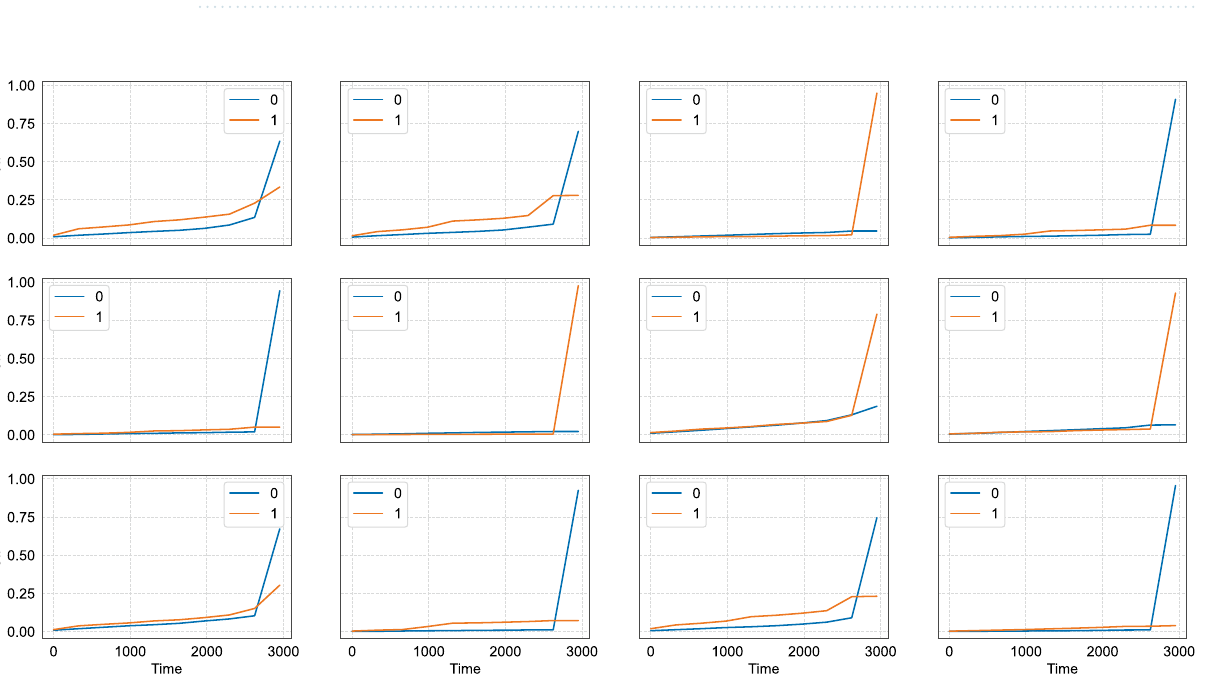
Table 3. Time-dependent C-statistics (C td -index) for predicting long-term noncardiovascular deaths or MACEs (cardiovascular deaths and recurrent ischemic events) with competing risks occurring (i) after discharge in 2161 individuals with premature ACS (55 years old or younger), total number of postdischarge events: 47 noncardiovascular deaths and 454 MACEs; (ii) 48 h after index ACS hospital admission ( global follow-up models), total number of events: 92 noncardiovascular deaths and 631 MACEs.